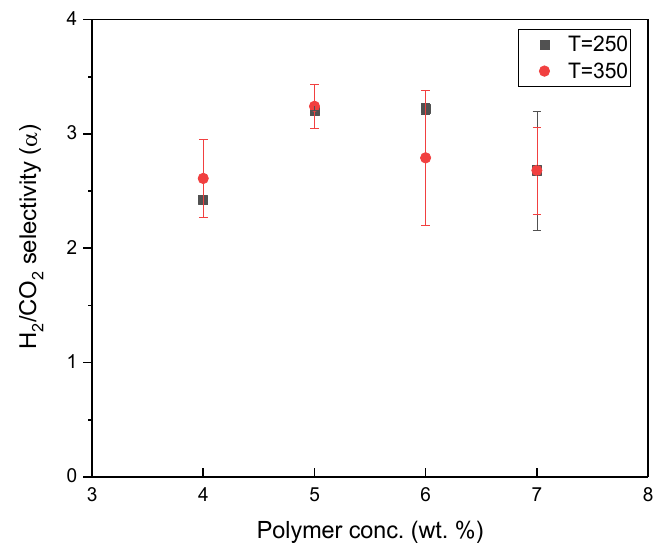
Polymer conc. (wt. %) Figure 8. Selectivity over H 2 / CO 2 gas pair of resultant TR membranes fabricated with di ff erent heating Figure 8. Selectivity over H 2 /CO 2 gas pair of resultant TR membranes fabricated with different heating temperatures. (The icon in black represents the temperature at 250 ◦ C; the icon in red represents the temperatures. (The icon in black represents the temperature at 250 °C; the icon in red represents the temperature at 350 ◦ C). temperature at 350 °C).